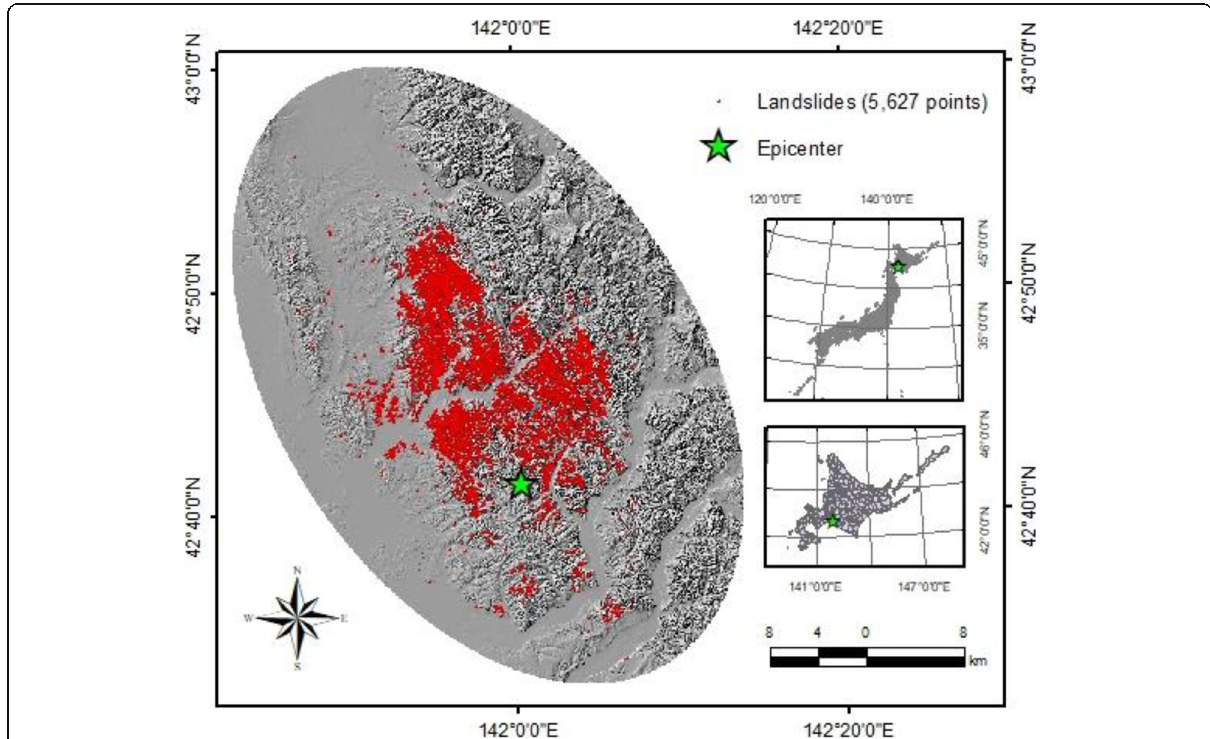
Fig. 1 Epicenter and inventory map of landslides triggered by the earthquake in Iburi region of Hokkaido, Northern Japan. (Modified from Zhang et al.